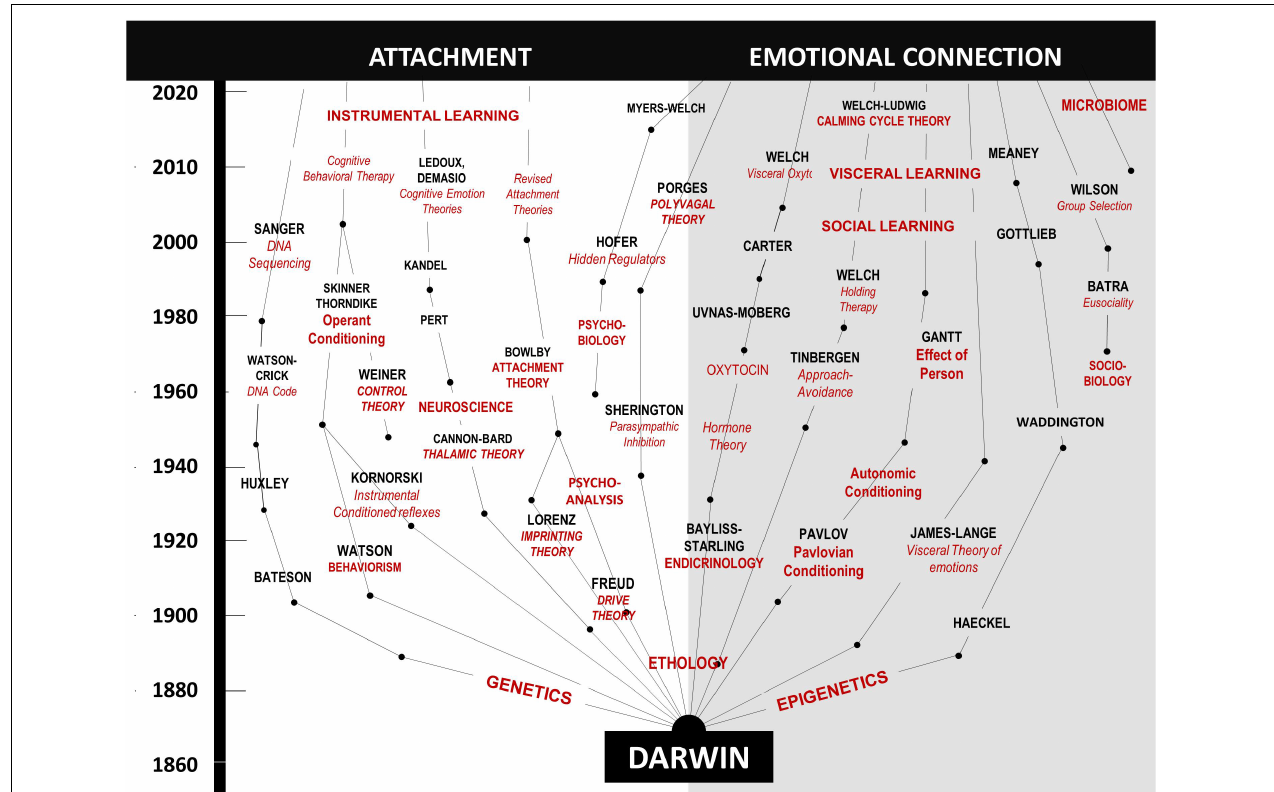
FIGURE 4 | A diagram showing the contrasting development of theories related to the dilemmas of instincts and control of heart rate since Darwin. On the left, are those theories leading to the behavioral construct of attachment. On the right are theories leading to the behavioral construct of emotional connection. The two sides highlight scientific arguments and theoretical conflicts in multiple fields, as outlined in Table 2 .